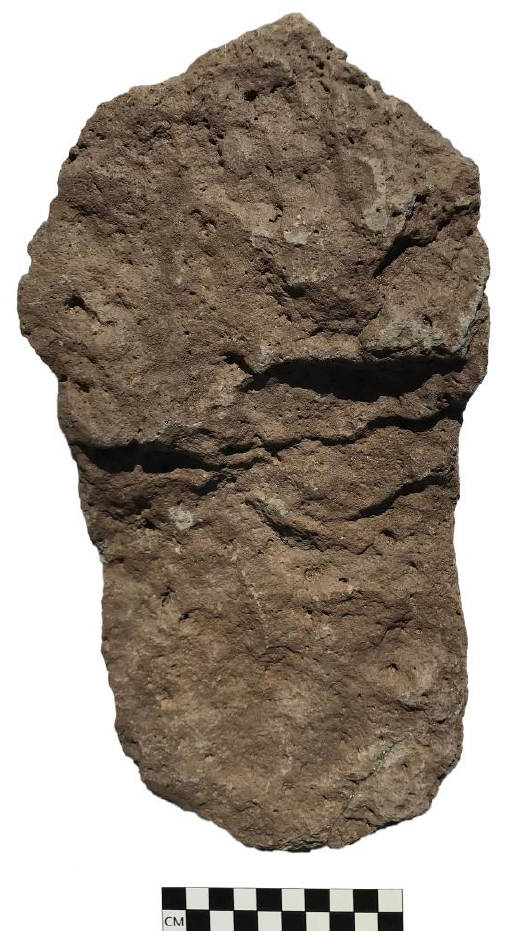
Figure 9. Specimen 2, a basalt sub-rectangular-shaped split-stone tool from the surface of a relict agricultural field. The working edge is pointed downward. (Photograph by James